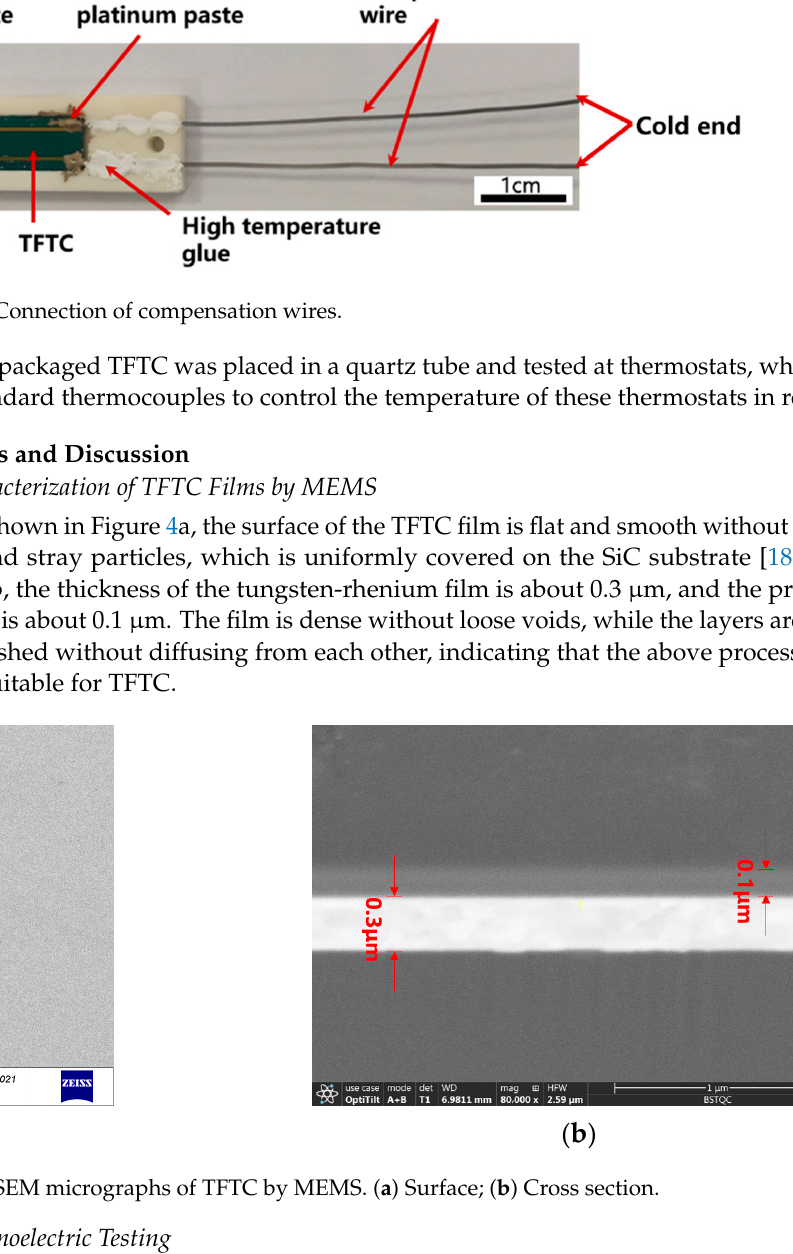
Figure 3. Connection of compensation wires.